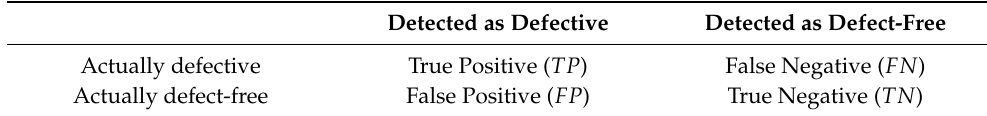
Table 1. Definition of TP , FN , FP , and TN in fabric defect detection. Detected as